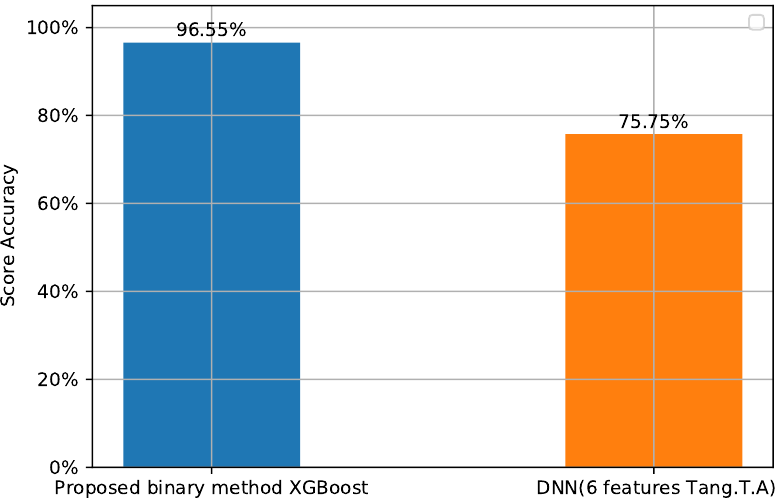
weighted­average ROC curve (area = 1.00) ROC curve of class dos (area = 0.99) ROC curve of class probe (area = 0.99) ROC curve of class r2l (area = 1.00) ROC curve of class u2r (area = 0.98)